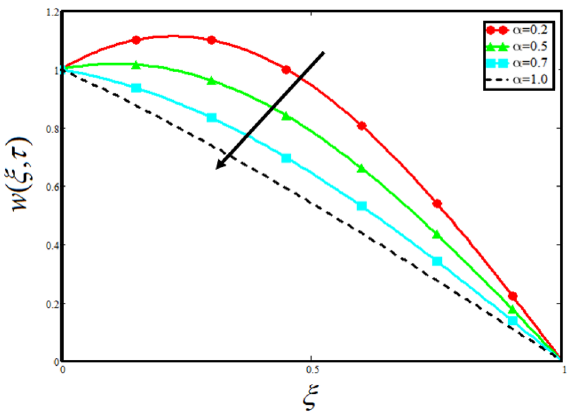
Figure 8. Variation in velocity of nanofluid against different values of α when τ = 1 , φ hnf = 0.02 , Pr = 21 , Gr = 4 , G = 2 , (cid:31) = 3 , β = 1.2 and Re = 1.2 .